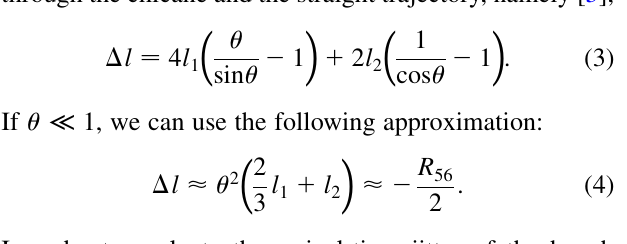
FIG. 1. Schematic layout of FERMI from the gun to the 350 MeV spectrometer line; the bunch arrival monitor is just beyond